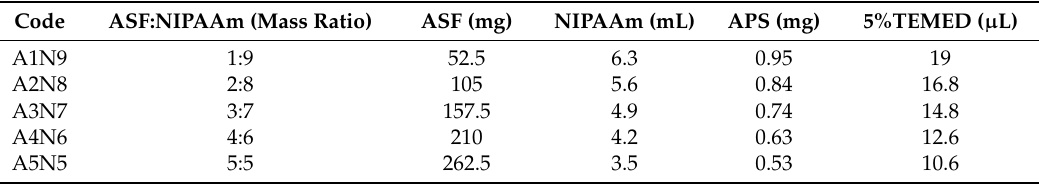
Table 1. The formulations of ASF/PNIPAAm composite hydrogels.